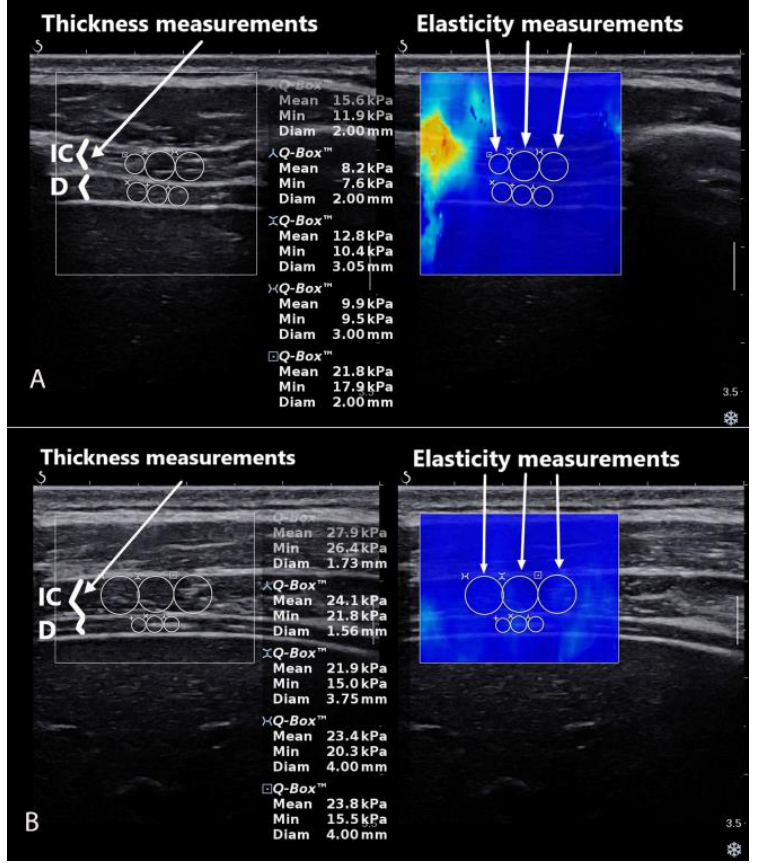
Figure 2. Data extraction from the images collected in SWE mode in transverse ( A ) and longitudinal ( B ) probe view. D — diaphragm; IC — intercostal muscle.